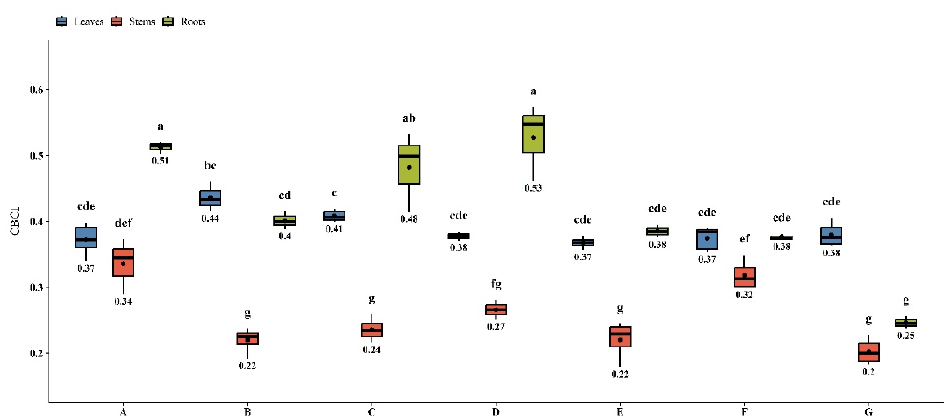
Figure 4. Comprehensive bio-concentration indexes of M. × giganteus grown in TEs-contaminated soil in the presence of PGPB strains. Different letters indicate a significant difference between treatments.